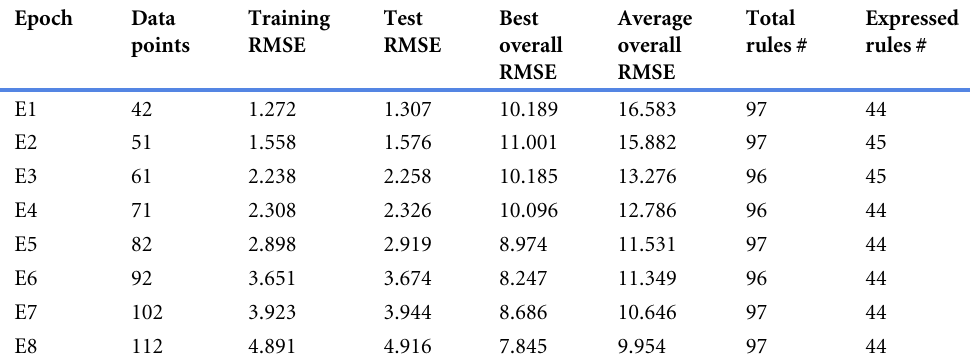
Table 4 Comparison of performance of the overall best POET models at generation 10,000 for all the